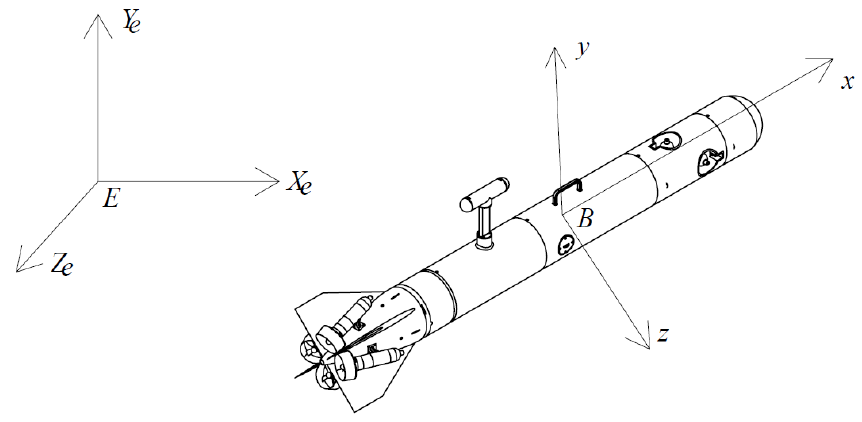
Figure 2. Reference frames of ZFAUV.